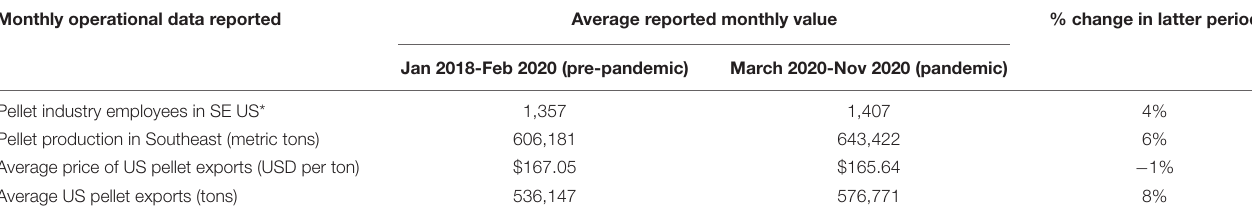
TABLE 2 | Pellet supply chain monthly operational data averaged for periods pre- and post- onset of the COVID-19 pandemic. Monthly operational data